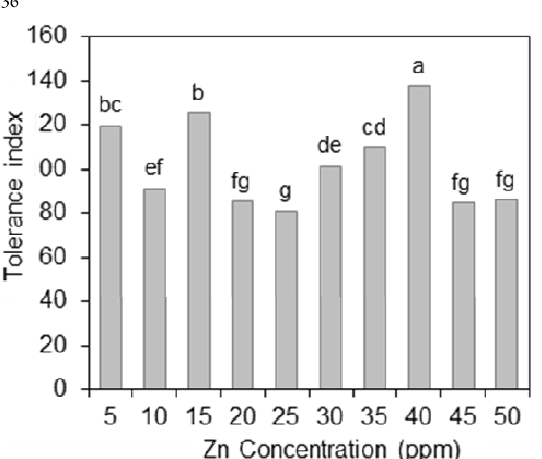
Fig. 3. Tolerance index of Talinum portulacifolium exposed to different concentrations of Zinc. Bars bearing same letter(s) are not significantly (P>0.05) different according to Duncan’s Multiple Range Test